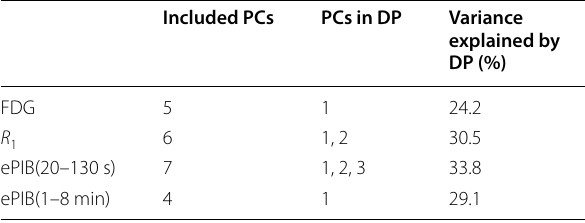
Table 2 Composition of principal components (PC) in the disease pattern (DP) of each imaging method Included PCs